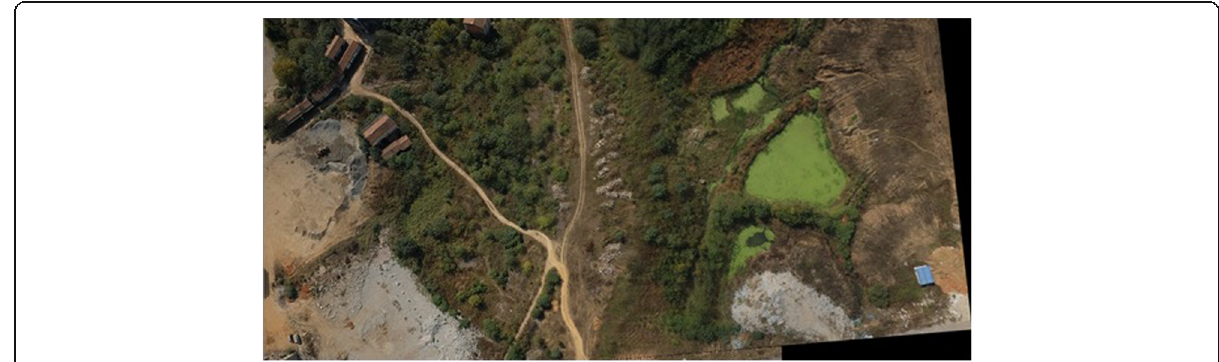
Fig. 39 Image after processing the stitching